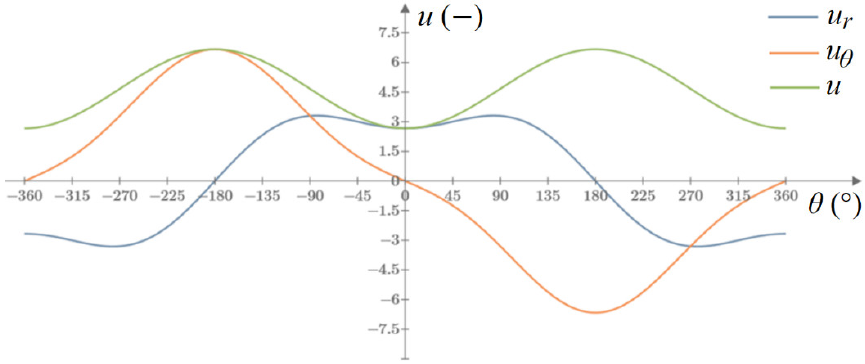
Figure 8. A plot of displacements around the tip of Griffith’s crack for any radius. The difference between the subroutines is that the stresses at the integration points are not read, but the displacements at the nodes are. In the URDFIL subroutine, the resultant displacements are read for at least 30 points around the crack tip, then the displacements are shifted so that at the crack tip, as in the Westergaard’s formula, the displacements are zero (because the model usually moves during the simulation). The displacements are reduced to a unit radius according to the relationship described in Equation (4). A 6th-order polynomial is fitted and the minimum is found.